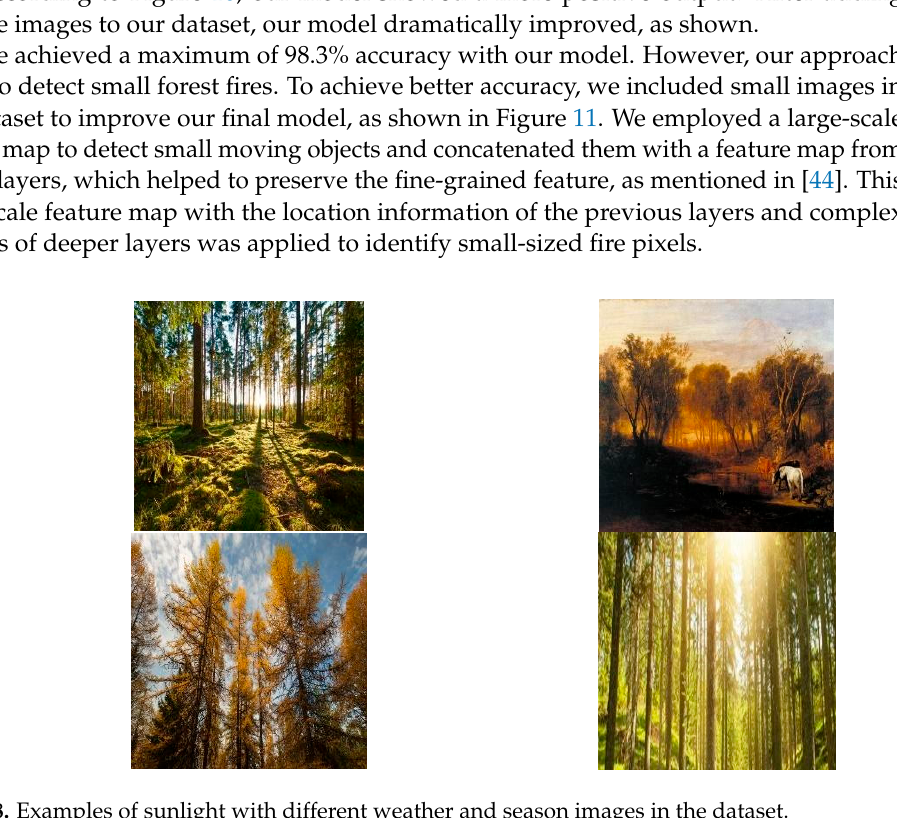
Table 5. Pre-trained weights using Detectron2.